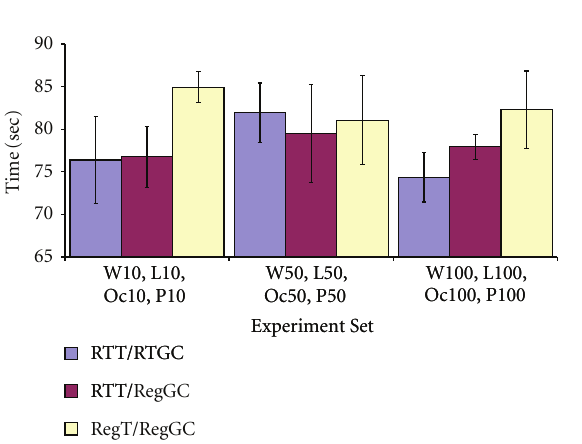
Figure 9: The average time it took the robot to travel from waypoint 1 to waypoint 2 for group 1.